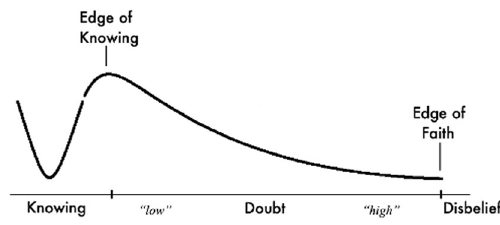
Fig. 1 Illustration of belief and disbelief paradigms. Two cognitive styles (knowing & doubt) are embedded in the former